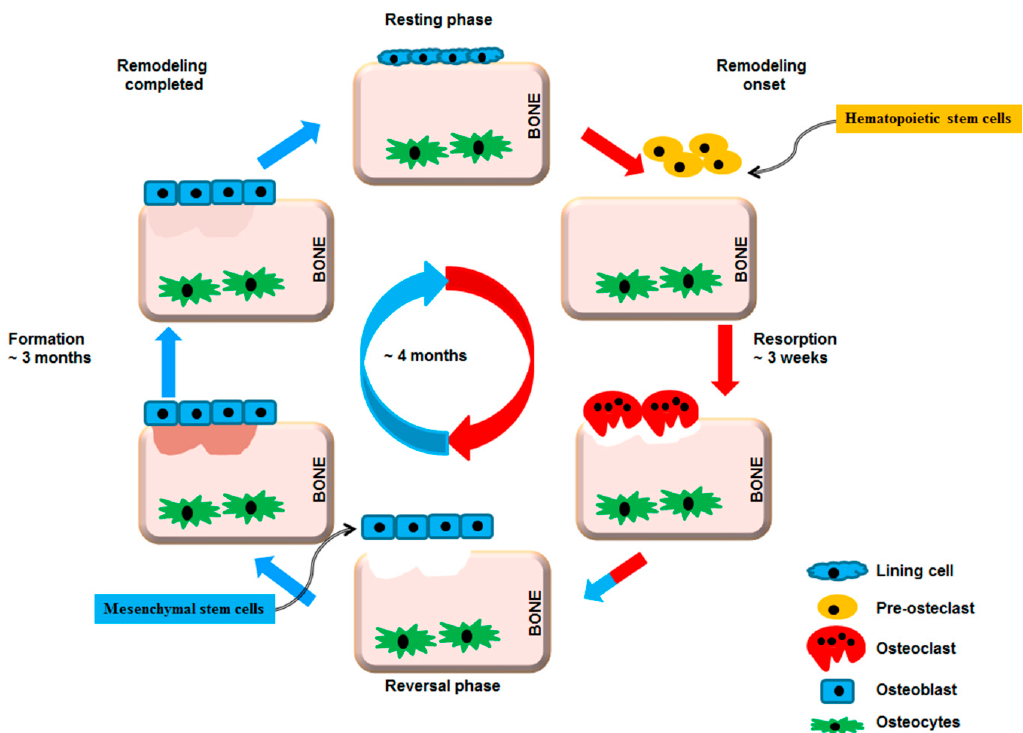
Figure 1. Bone remodeling cycle. A remodeling cycle is initiated by osteoclasts that solubilize bone mineral and degrade the matrix (resorption phase). Osteoclasts originate from hematopoietic stem cells which differentiate first into pre-osteoclast cells which fuse to form multinucleated cells (activated osteoclasts). Monocytes/macrophages remove debris (reversal phase), followed by a bone formation phase performed by osteoblasts, producing osteoid matrix which will mineralize. Growth factors are released from the bone matrix during resorption, which increase the pre-osteoblast population in order to replace damaged bone surfaces.